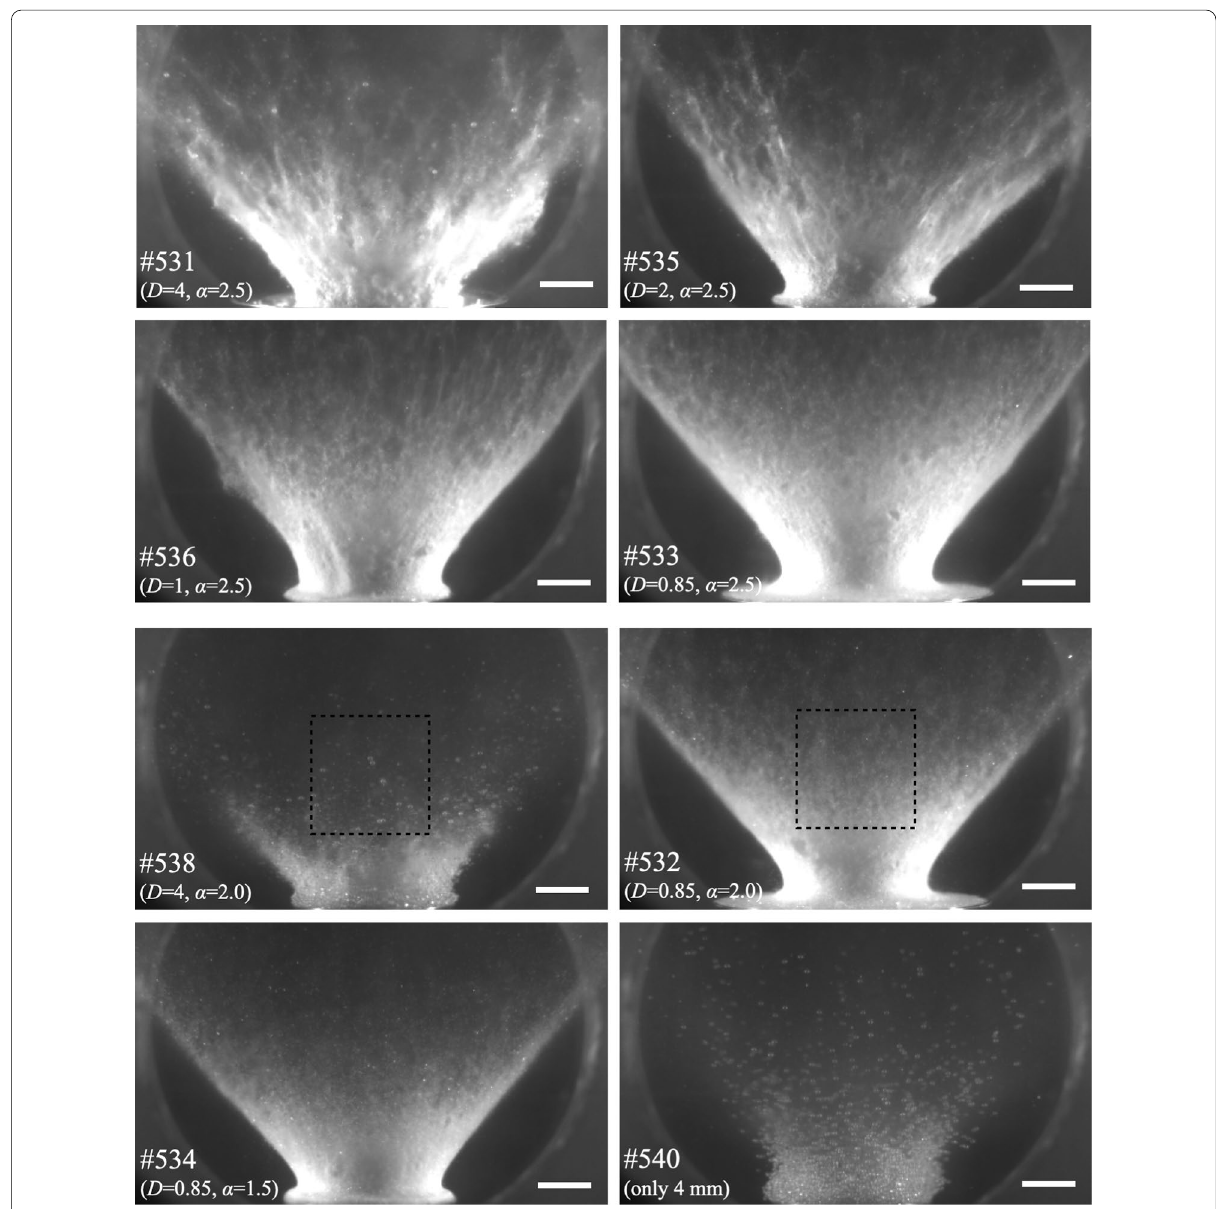
Fig. 3 Ejecta curtain captured by a high-speed camera at 28 ms after the impact. Projectile impacted vertically from the top. We investigated the intensity within an area in each image (examples of the area are indicated by the squares in the images of #532 and #538) to evaluate the spatial concentration of particles. The white horizontal line in each frame is a spatial scale indicating 50